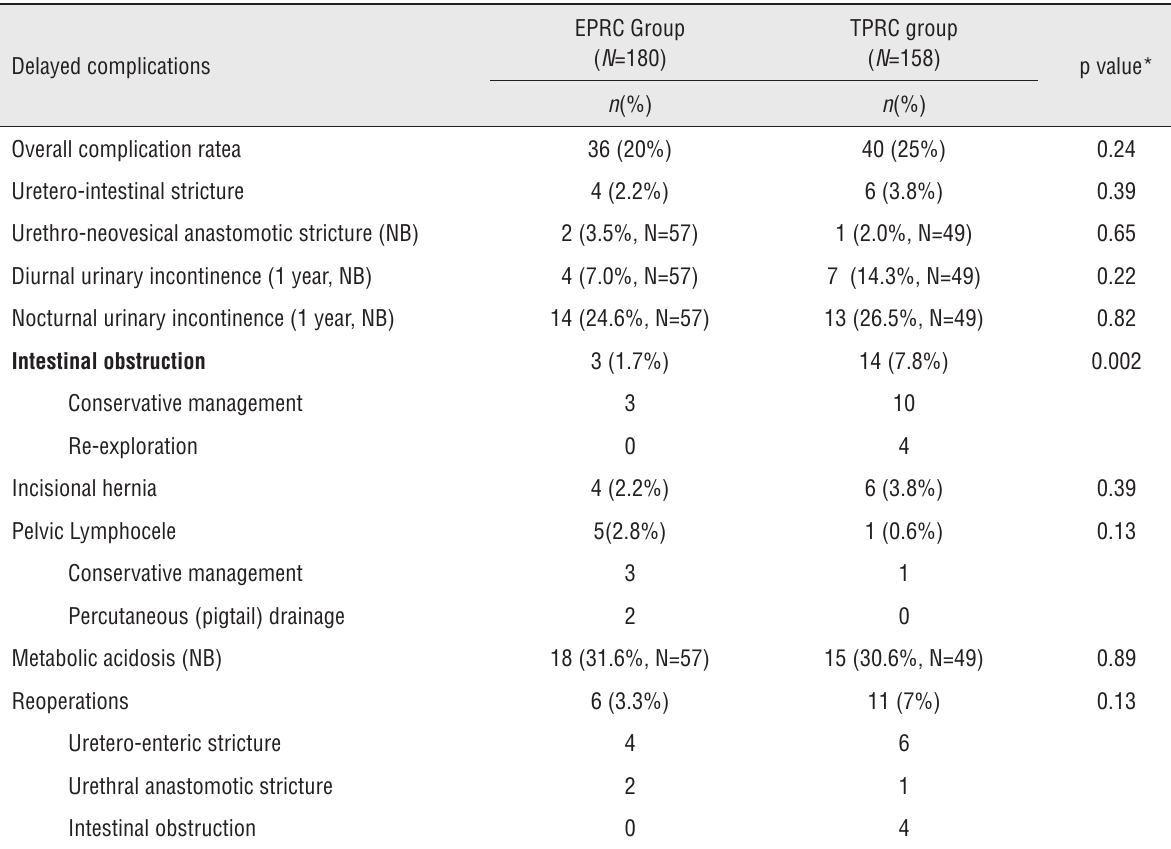
Table 4 - Delayed